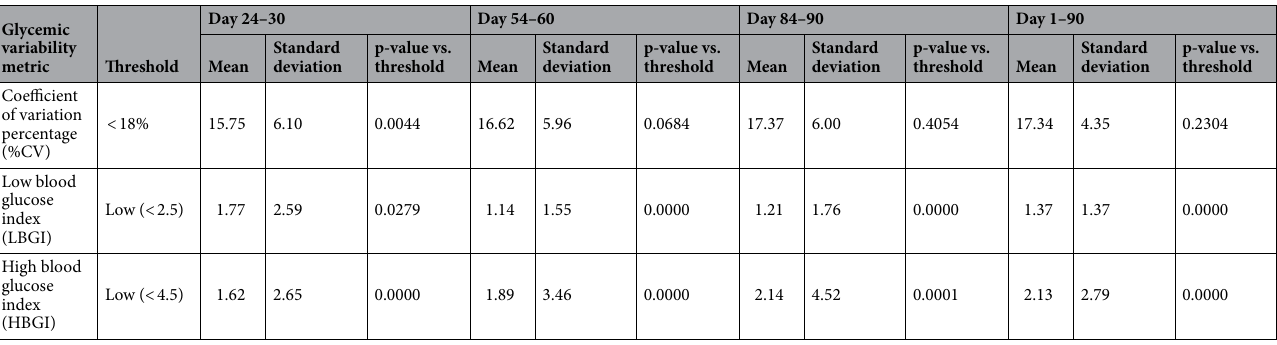
Table 3. Glycemic variability metrics.